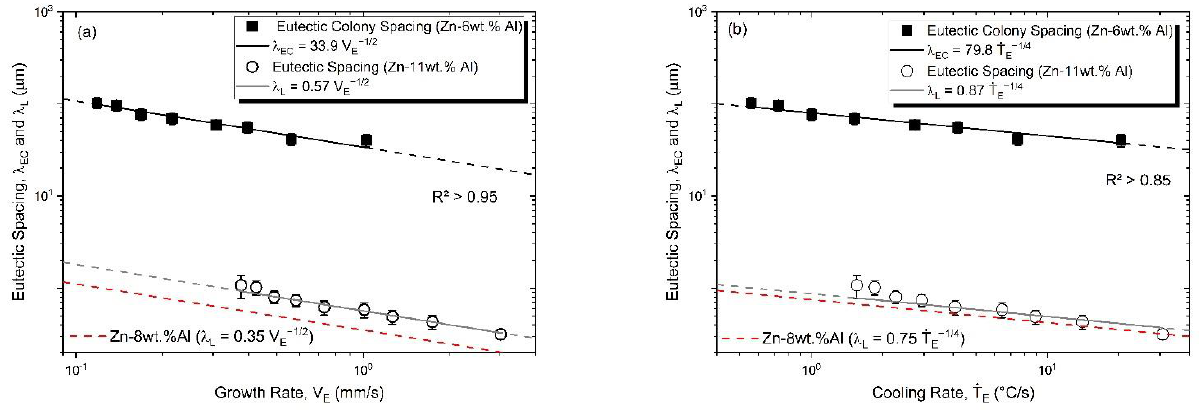
Figure 15. Eutectic cell and eutectic lamellae spacing as a function of solidification thermal parameters of the Zn–Al alloys: ( a ) growth rate and ( b ) cooling rate.